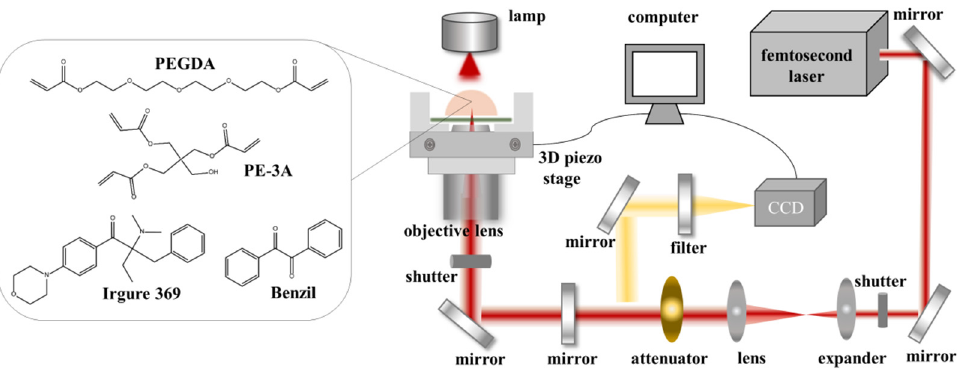
Figure 1. Chemical structure of the photoresist and the schematic of femtosecond laser TPP system.